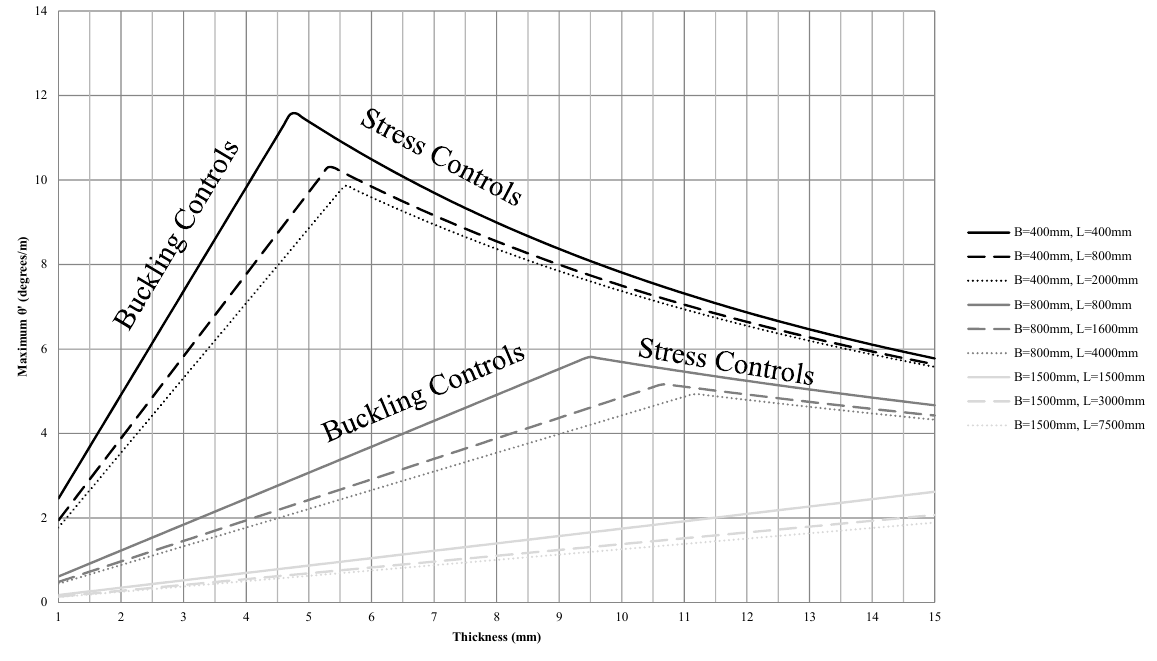
Fig. 15 Maximum Achievable Twist for Various Short Dimensions Controlled by Buckling and